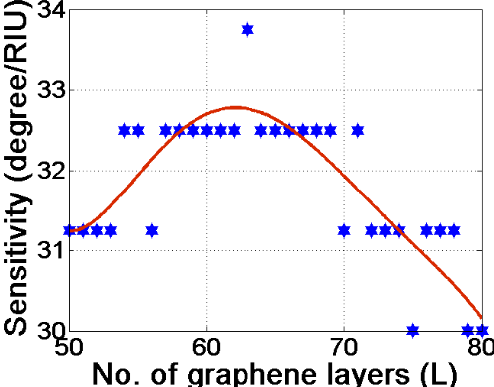
Figure 6. Sensitivity variation with no. of graphene layers for gas sensing probe (without silicon) with 50 nm of Au. Maximum sensitivity is calculated to be 33.75 degree/RIU. The star symbols are simulated data points, which are fitted with red line.